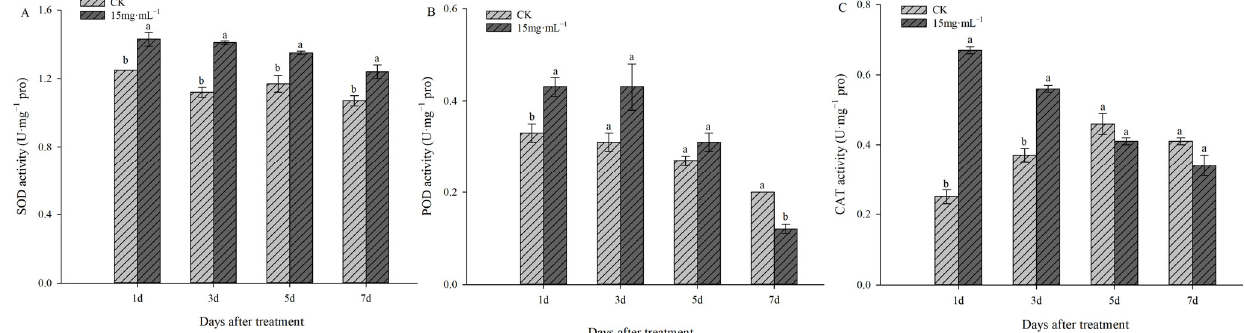
Figure 2. The impact of 15 mg ∙ mL − 1 GSE on superoxide dismutase (SOD) activity ( A ), peroxidase (POD) activity ( B ), and catalase (CAT) activity ( C ) of M. sorghi across successive treatments. CK, 10% ethanol. Data are mean ± SE. Different letters (a, b) for the same time in each figure indicate significant differences ( α = 0.05).